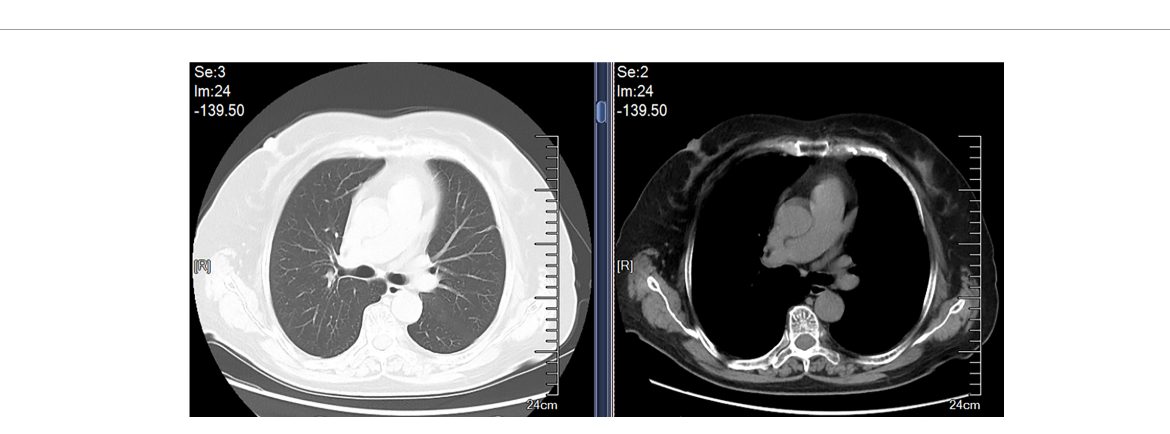
FIGURE4 Follow-up chest CT showed a complete withdrawal of the left pleural